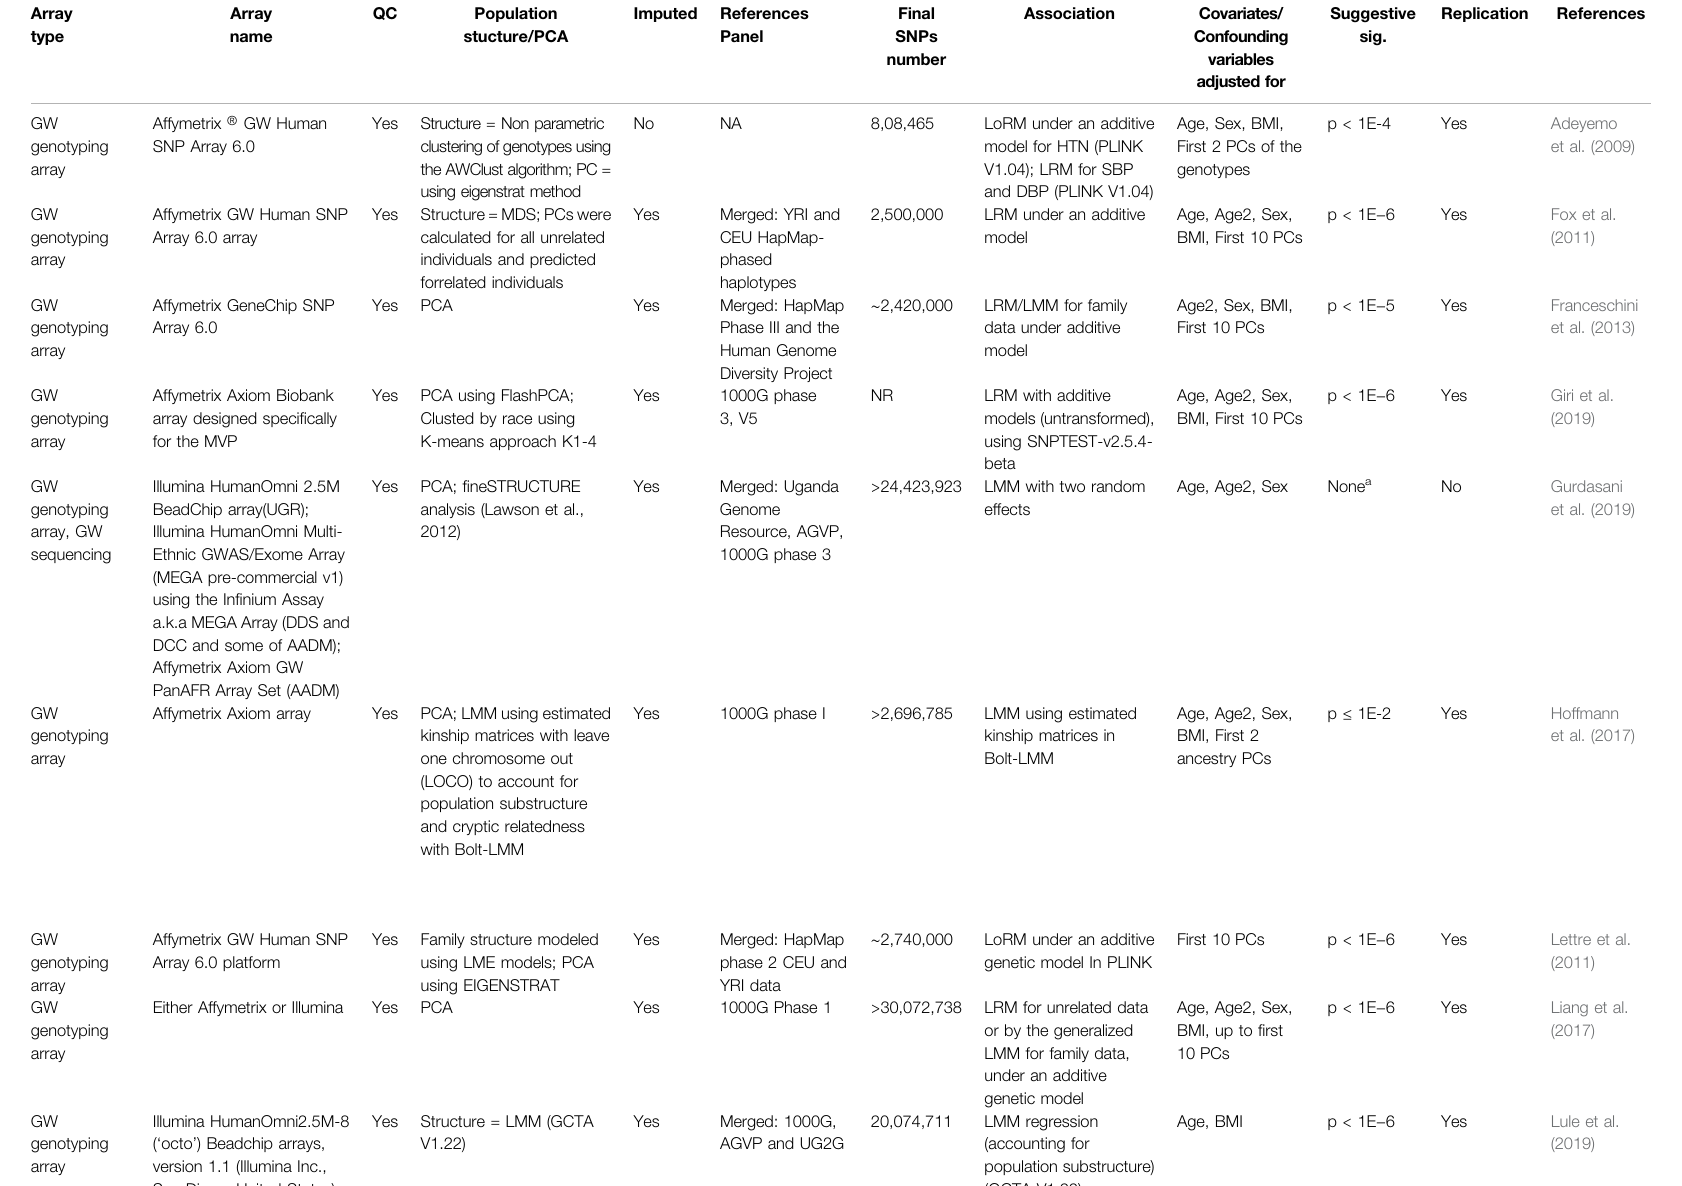
TABLE 3 | Genotype and analyses characteristics of the 12 eligible